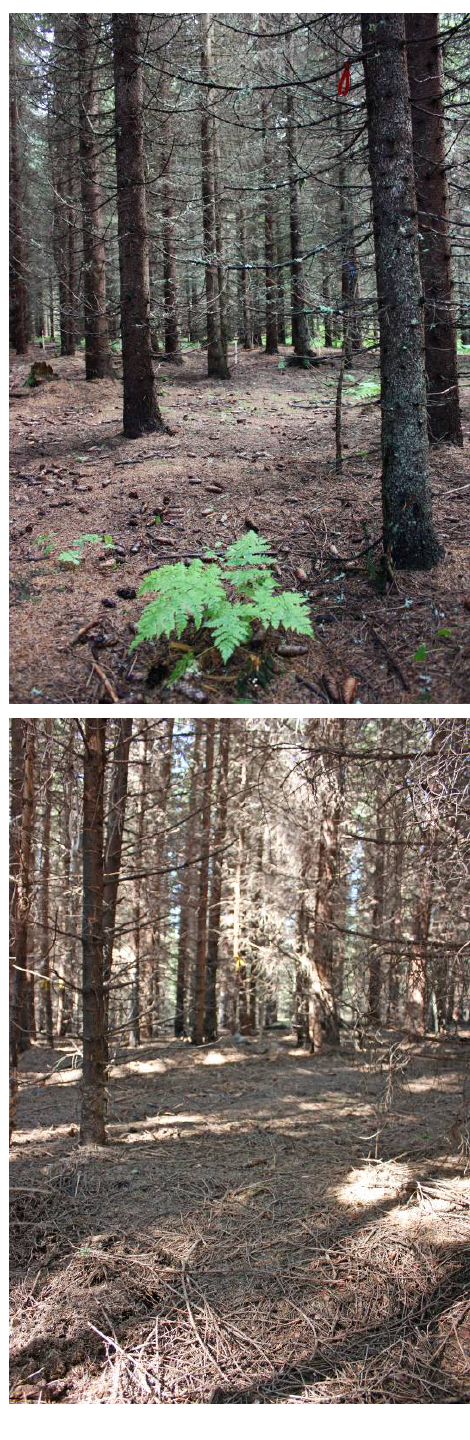
Figure 1. Contrasts in stand characteristics between unfertilized control plots ( left ) and stands that have been intensively fertilized for 20 years ( right ). Photos in the top row are from the Flakaliden experimental site (64 ° 07’N, 19 ° 24’E) located in northern Sweden and in the bottom row are from the Asa experimental site (57 ° 08’N, 14 ° 45’E) in southern Sweden [22,24], Photo Joachim